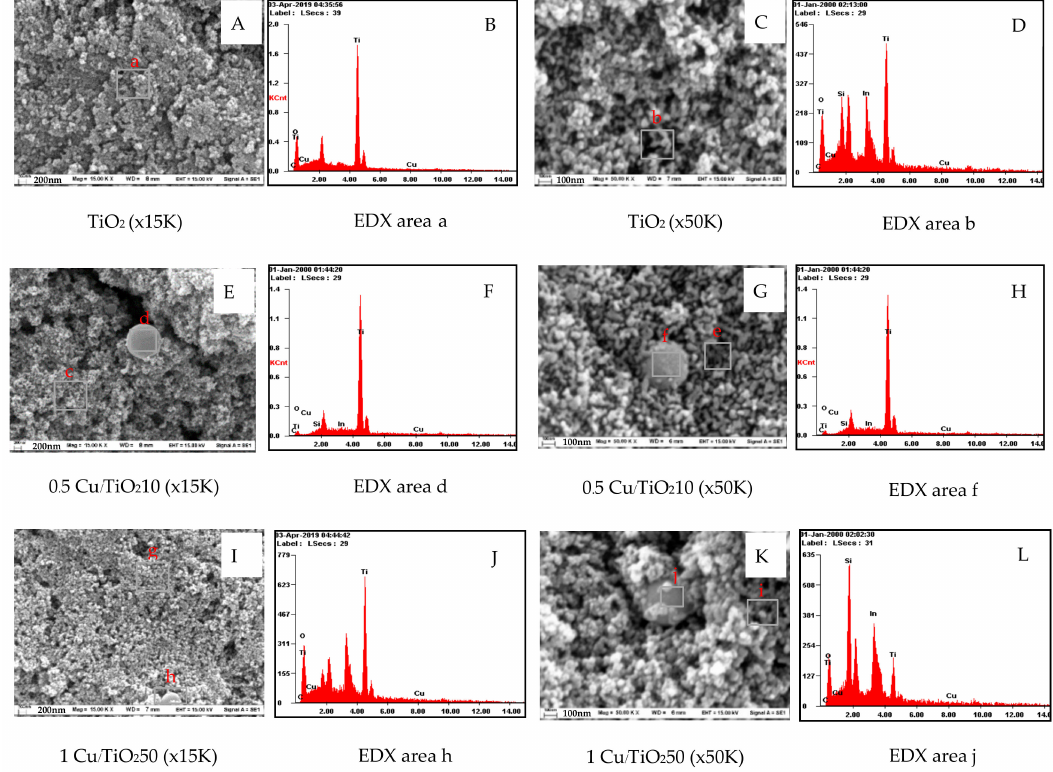
2 -TiO 2 composite